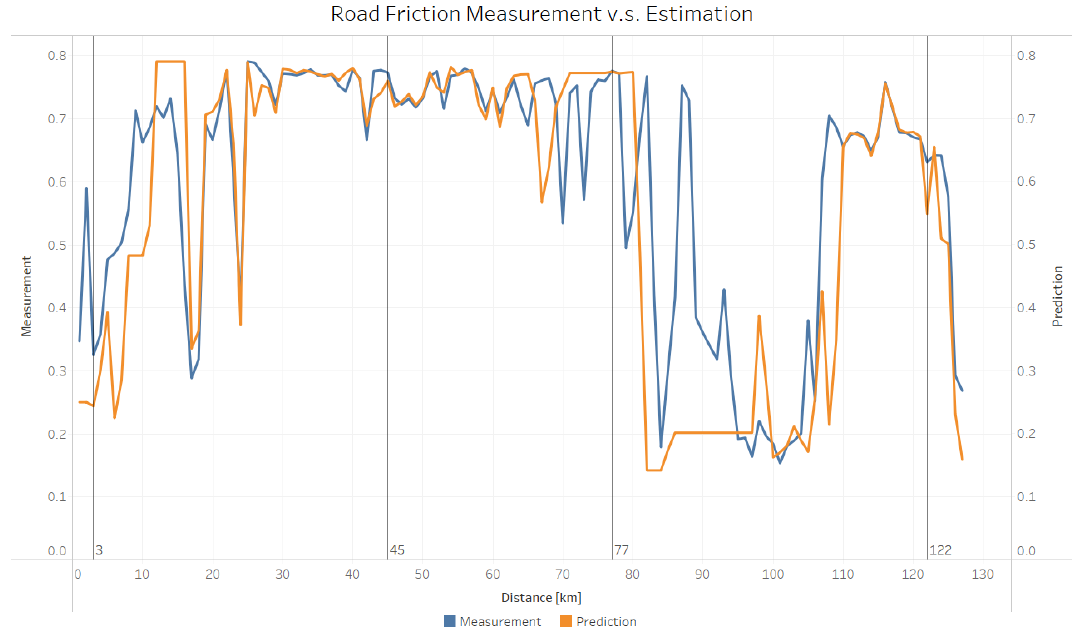
Figure 8. Interpolated (orange) and observed (blue) values of friction over the study area.